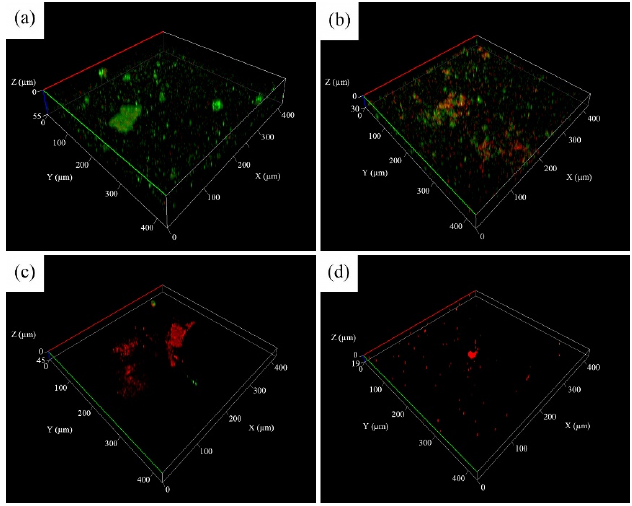
Figure 11. CLSM images of Tamsui inocula incubated for 336 h with varying concentrations of composite biocides under ( a ) no treatment, ( b ) TB, ( c ) 3TB, and ( d ) 5TB.